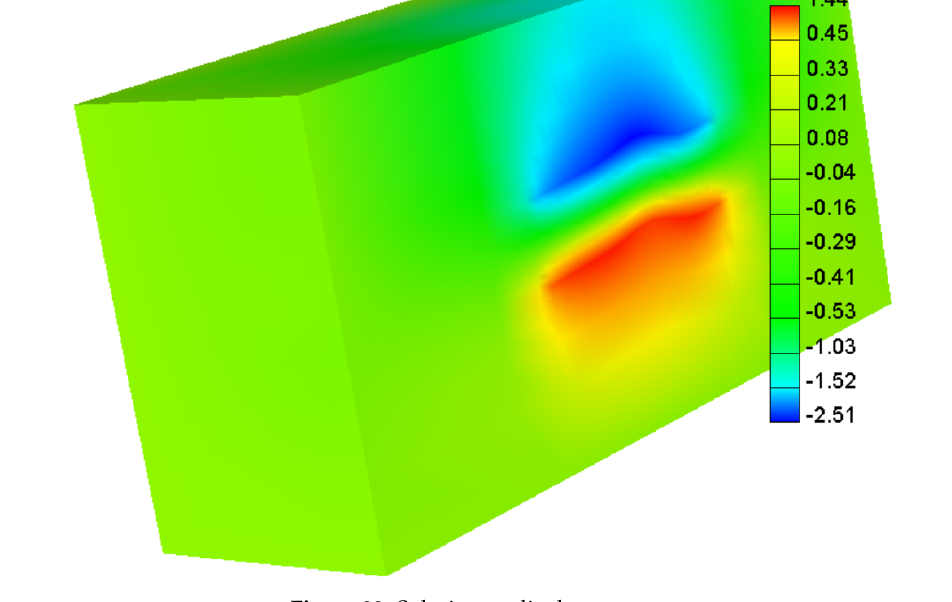
Figure 23. Solution u z displacement.